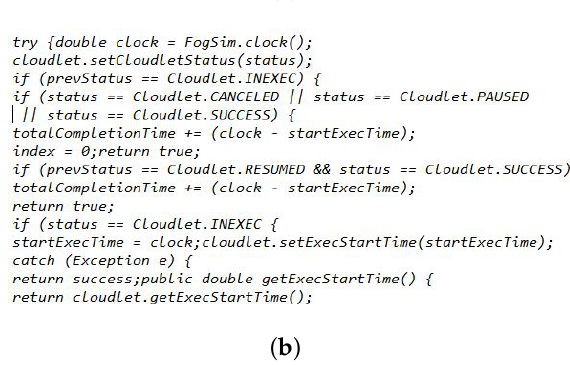
Figure 10. ( a ) iFogSim Header Files ( b ) Execution Time